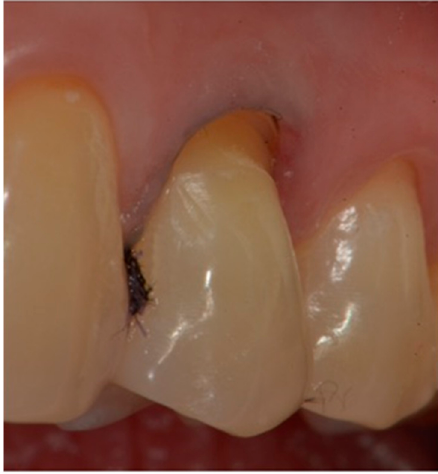
Figure 3. A retraction cord inserted in the gingival sulcus to expose the apical margin.